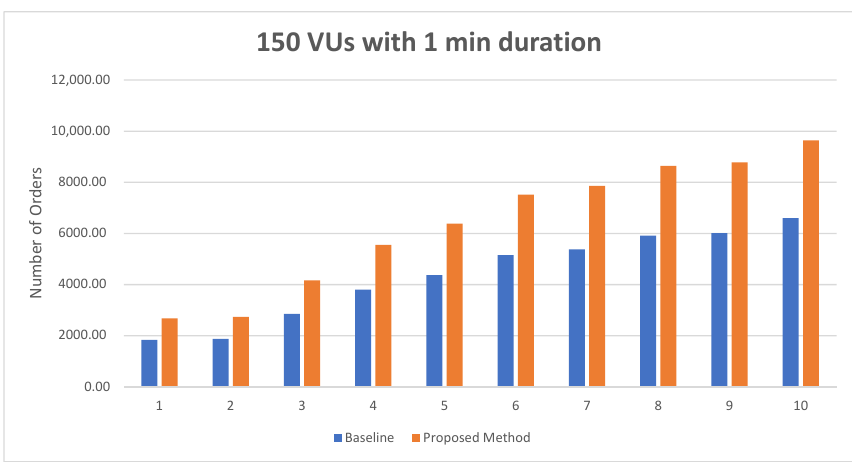
Figure 18. Load Testing—150 virtual users with 1 min duration.